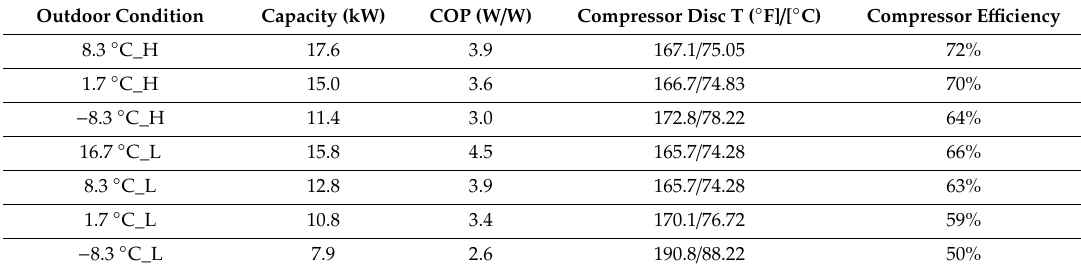
Table 4. Predicted heating performance using